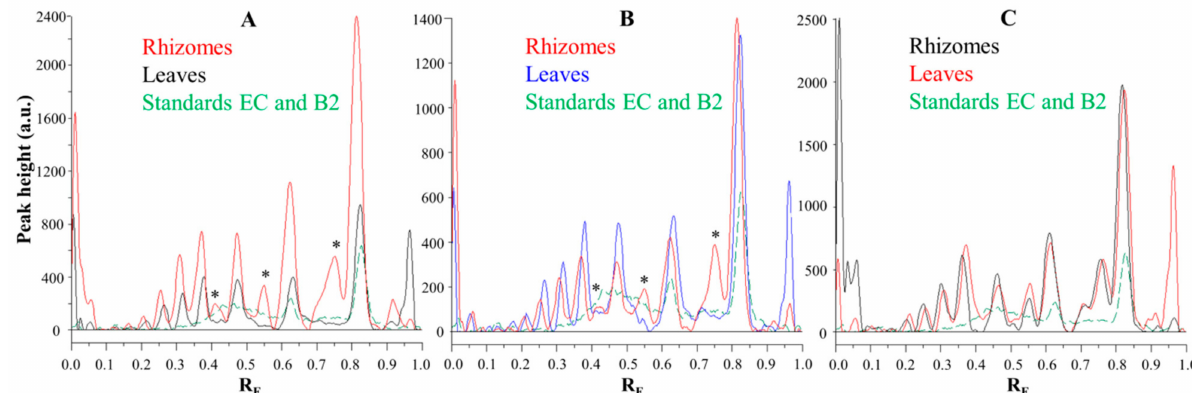
Figure 6. Comparisons of the videodensitogram fingerprint profiles of STSs (1 µ L, 50 mg/mL) from leaves and rhizomes of the same knotweed species (Japanese ( A ), Bohemian ( B ) and giant ( C ) knotweed) with the videodensitogram of standards ( − )-epicatechin (EC; R F = 0.82) and procyanidin B2 (B2; R F = 0.63) (30 ng; dashed green line). The videodensitograms were obtained in absorption mode by image analysis of the HPTLC silica gel plates after the development with toluene–acetone– formic acid (3:6:1, v/v ) and after the derivatization with DMACA detection reagent. The asterisks (*) in dicate peaks that are only present in the rhizomes of Japanese and Bohemian